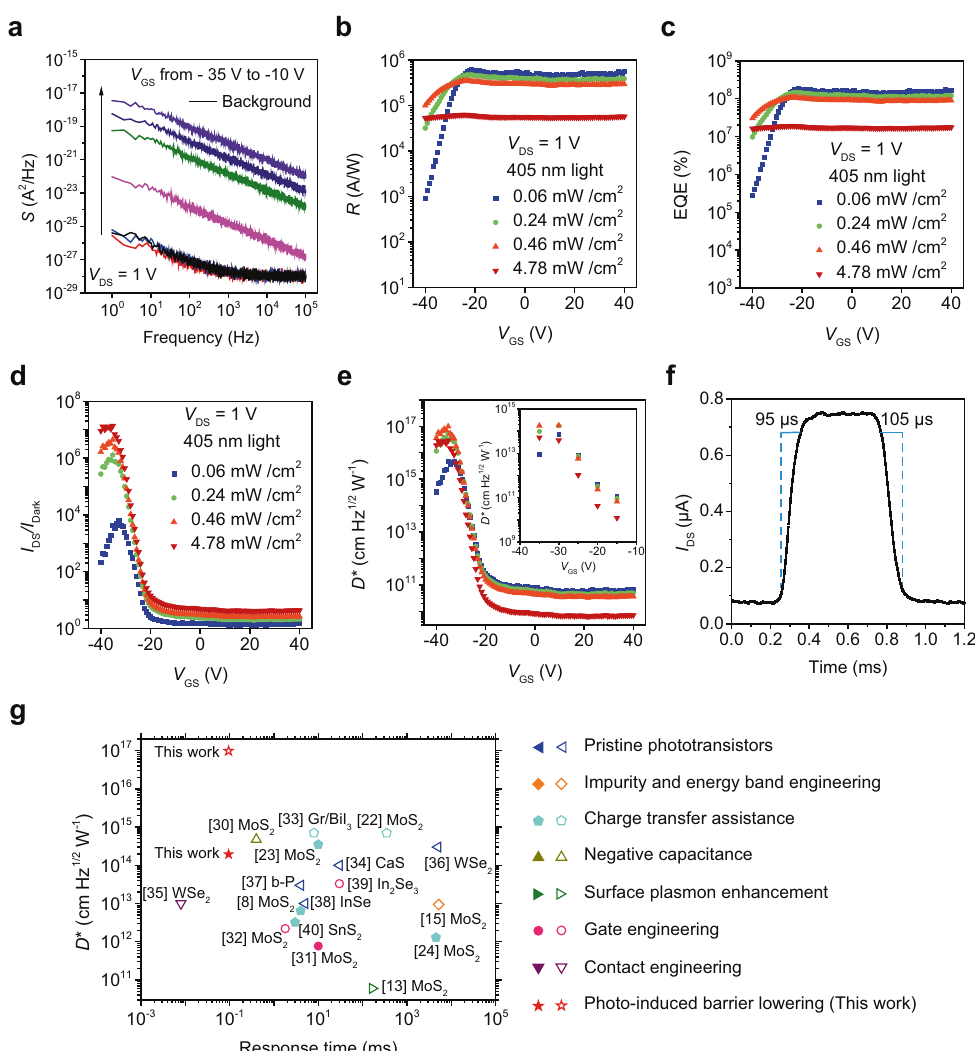
Fig. 2 Optoelectronic performance of the phototransistor. a Density spectral ( S ) as a function of frequency at V DS = 1 V with different gate voltage V GS of 0 V, − 15 V, − 20 V, − 25 V, − 30 V, and − 35 V as well as the background noise from top to down. b Responsivity ( R ) as a function of V GS . R = ( I DS − I Dark )/ P P V fi ciency (EQE). EQE = hcR λ − 1 e − 1 , where h is the Planck constant, c the speed of in , where in is power density of light. c GS -dependent external quantum ef light, λ the wavelength of light (405 nm) and e the electron charge. d V GS -dependent light – dark current ratio ( I DS / I Dark ). e V GS -dependent detectivity ( D *), which was calculated using intrinsic S . D * = ( AB ) 1/2 R / S 1/2 , where A is the active area of ~2.5 μ m 2 , B is the bandwidth (1 Hz). Inset: V GS -dependent D *, which was calculated using measured S . f Response speed of the phototransistor showing the rise time of 95 μ s and the fall time of 105 μ s. g Benchmark of the phototransistor in this work demonstrating a high D* compared to previously reported 2D materials based photodetectors. The D* represented by hollow polygon were calculated by estimated noise, and represented by solid polygon were calculated using measured